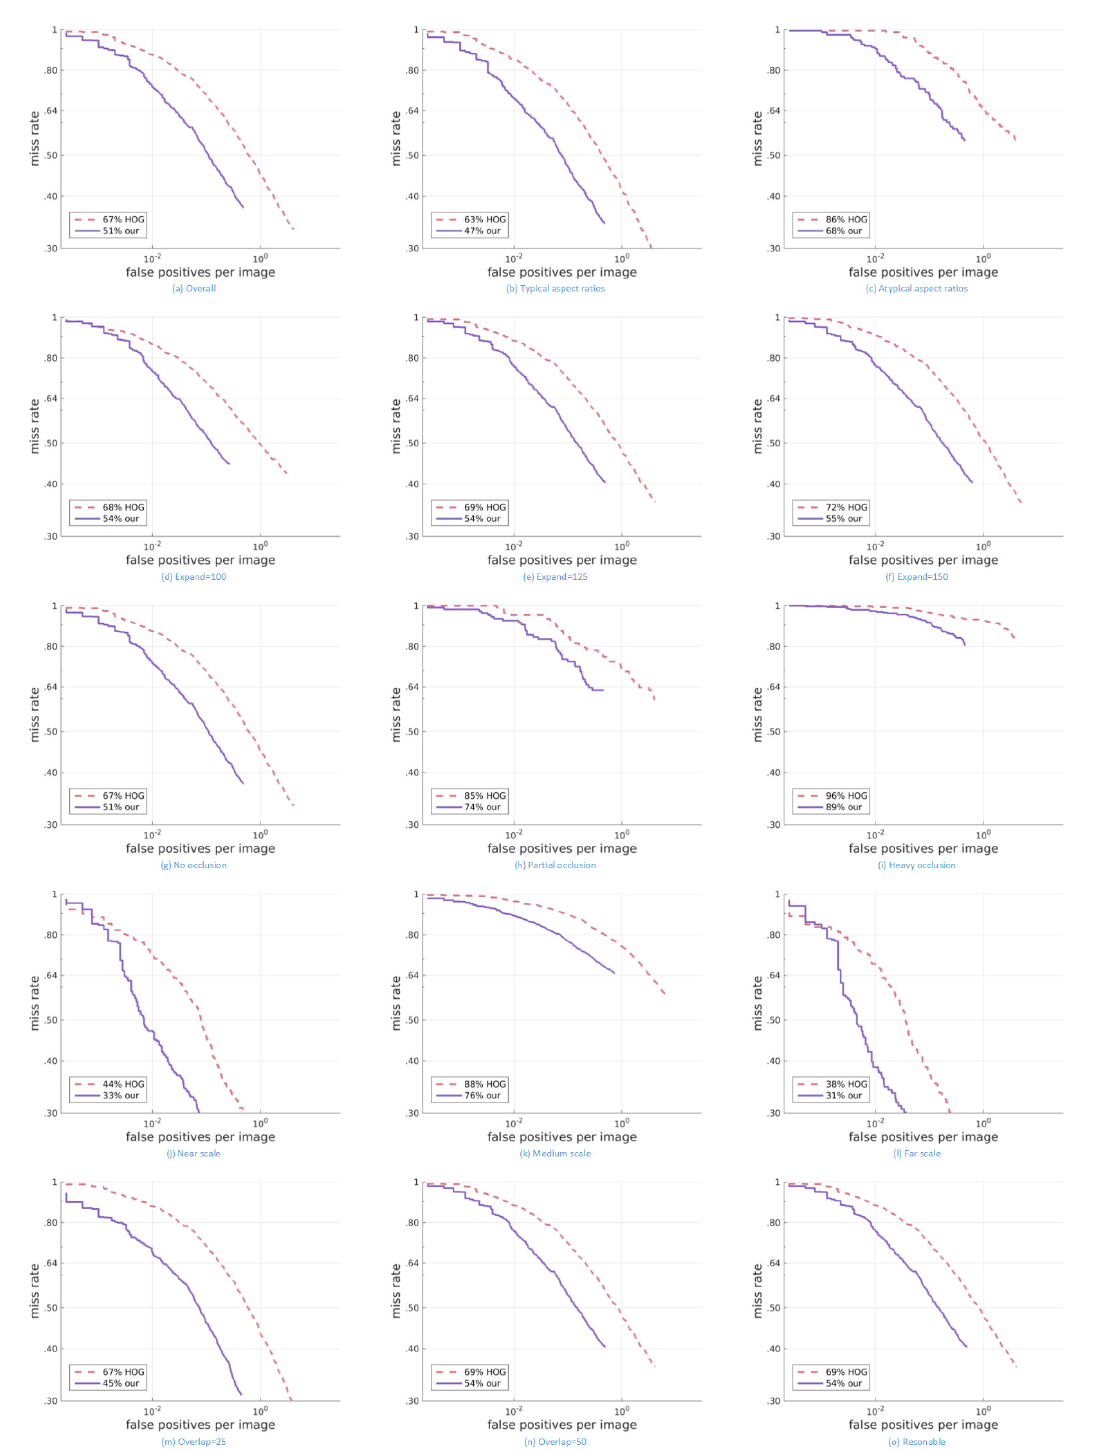
Figure 8. Result on the Caltech Pedestrian Detection Benchmark compared with HOG +